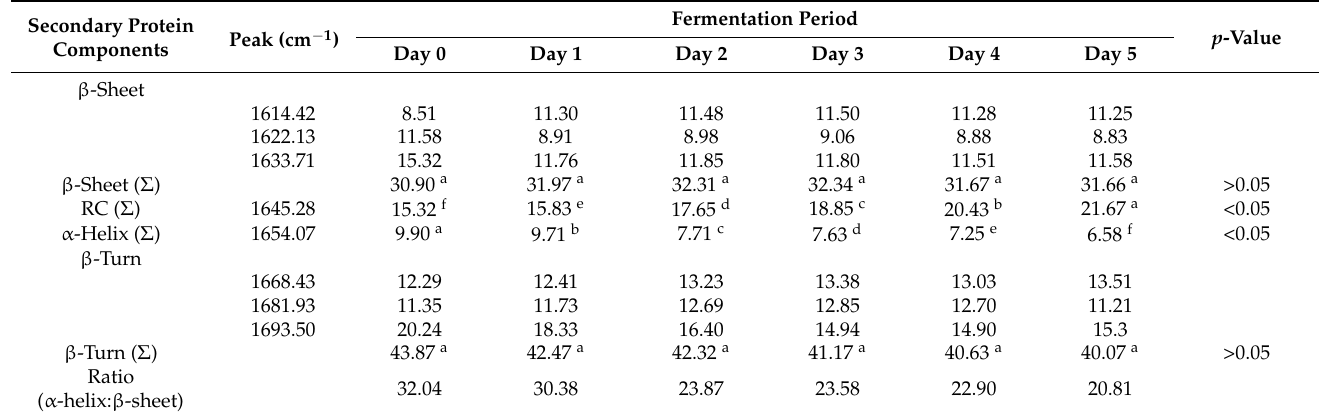
Table 3. Evaluation of the proportion of secondary protein components of the unfermented and fermented lentil–casein protein complex at a ratio of 1.0:0.1 (LCPC 1.0:0.1). Secondary Protein